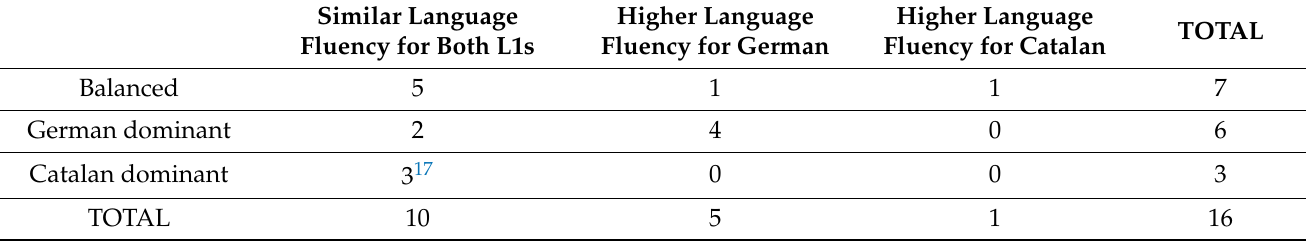
Table 4. Children’s classification according to language dominance (MLUD) and language use (Flu- encyD).